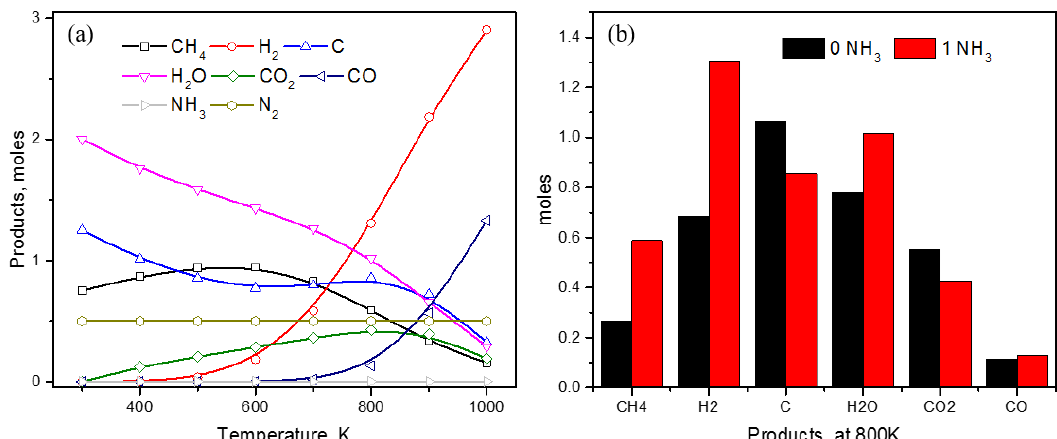
Figure 2. ( a ) Product distribution in ammonia-assisted methane dry reforming (CH 4 + CO 2 + NH 3 ); ( b ) comparison in product amount at 800 K with and without NH 3 addition.